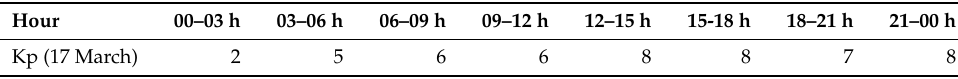
Table 1. Hourly Kp for the 17 March 2015.